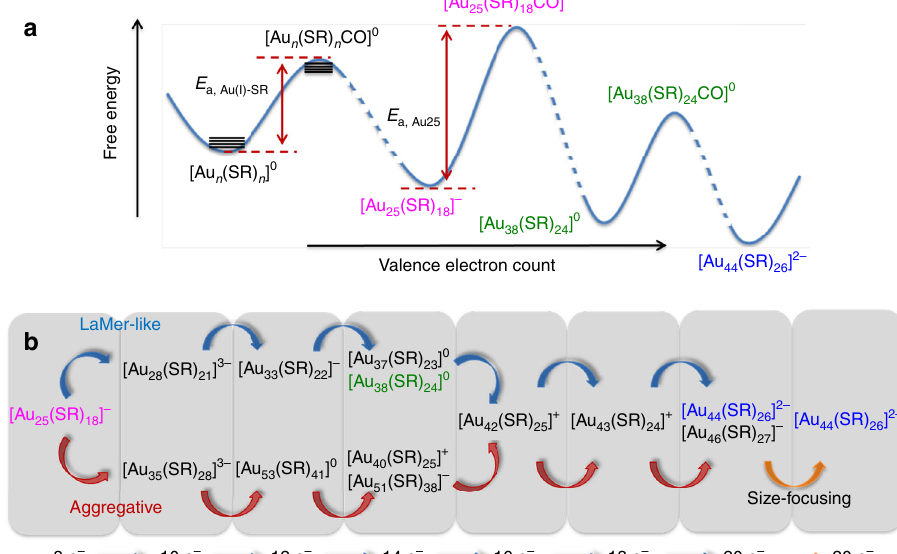
Figs. 6a, b, the zoom-in ESI-MS spectrum of the CO-saturated pure [Au 25 (SR) 18 ] − aqueous solution shows representative peaks of [Au 25 (SR) 18 CO] − . The isotope analysis depicted in Fig. 6c